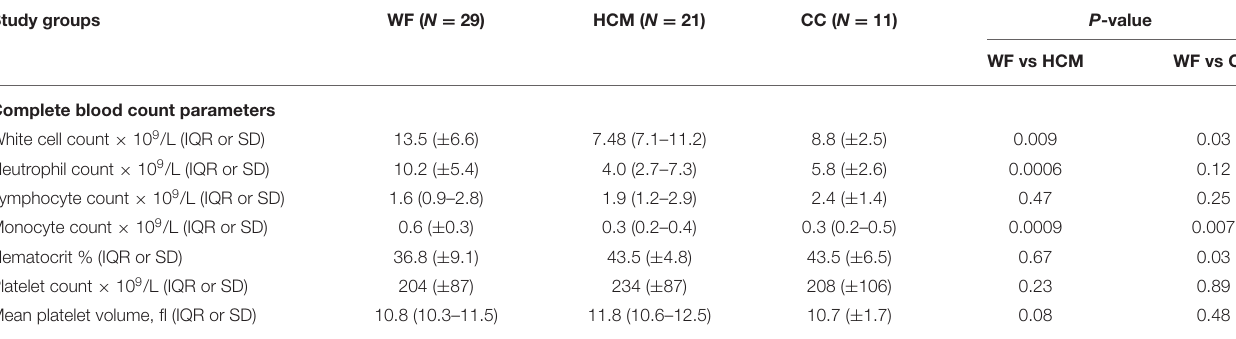
TABLE 1 | Summary of the complete blood count parameters of each study group. Study